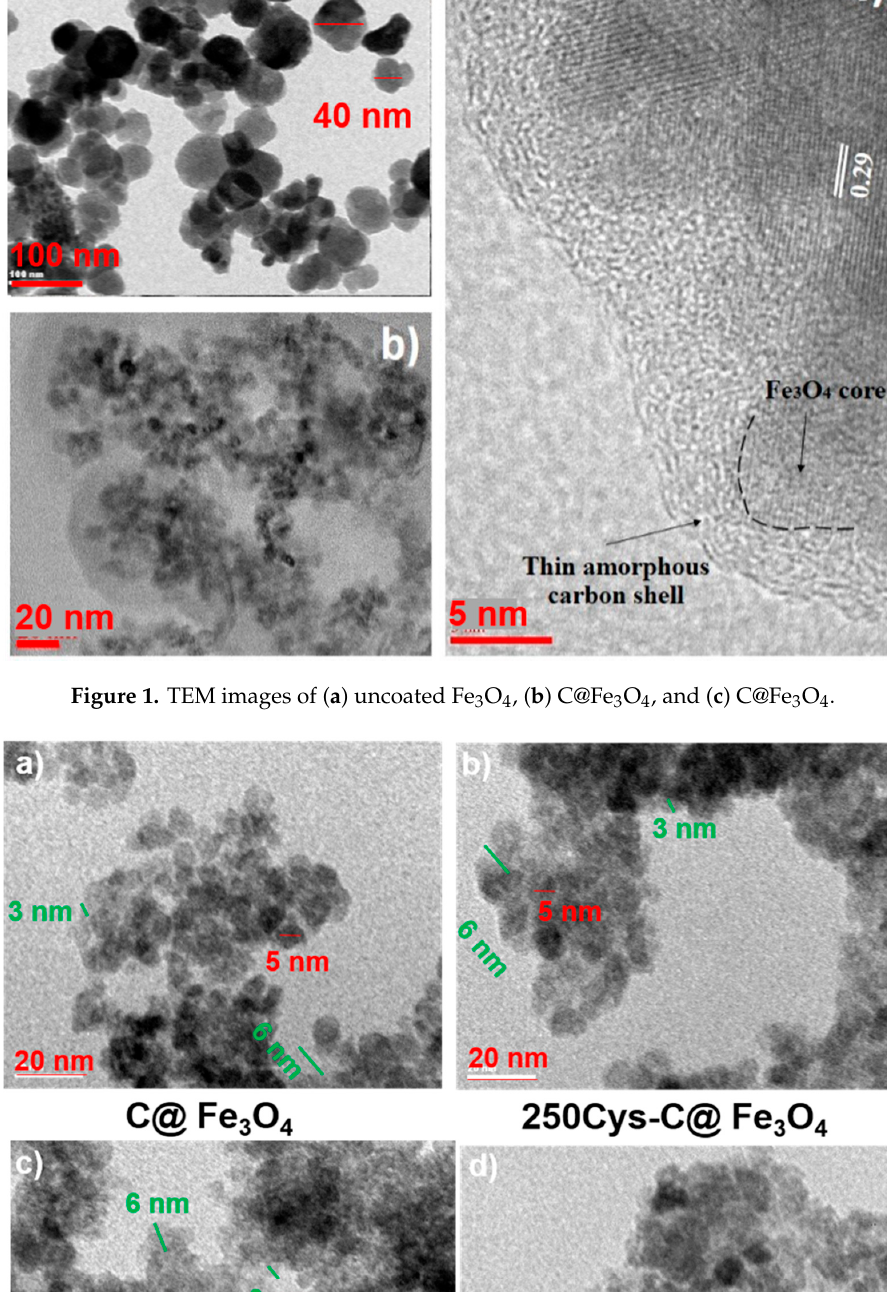
Figure 2. TEM images of ( a ) C@Fe 3 O 4 , ( b ) 250Cys - C@Fe 3 O 4 , ( c ) 500Cys - C@Fe 3 O 4 , and ( d ) 1000Cys - C@Fe 3 O 4